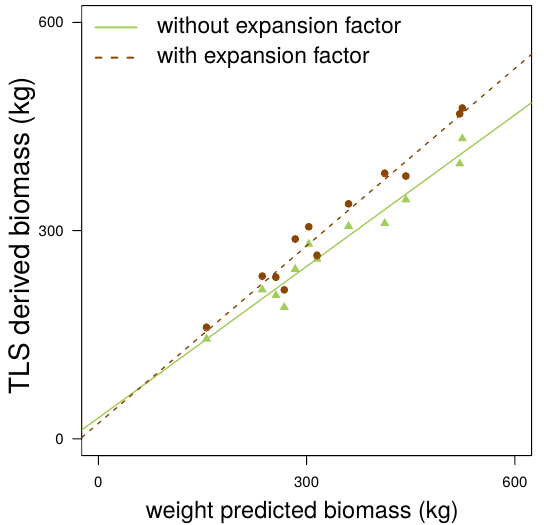
Figure 11. Two linear models utilizing both biomass weight of 12 E. fordii as independent and either the biomass TLS ( f( x ) = 0.73 x + 30.29, adj. r 2 = 0.95 ) or biomass TLS ∗ ( f( x ) = 0.85 x + 22.49, adj. r 2 = 0.96 ) as dependent